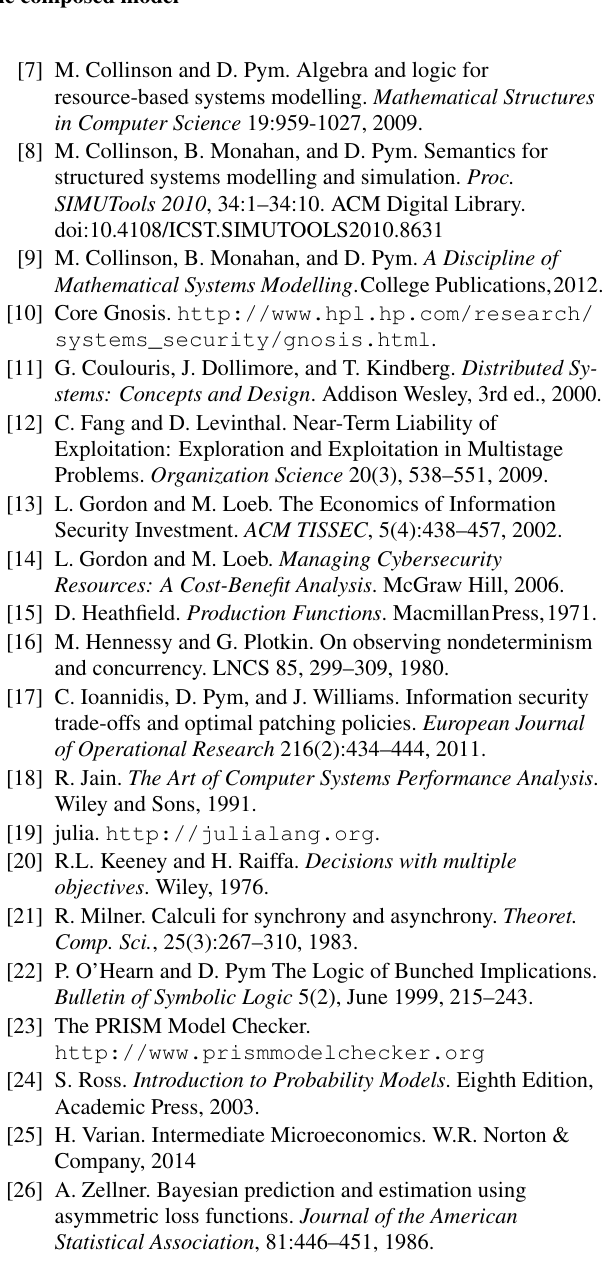
Table 3: Results from the composed